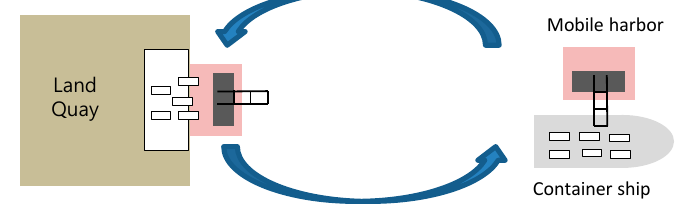
Figure 1. Mobile harbor (MH) system.